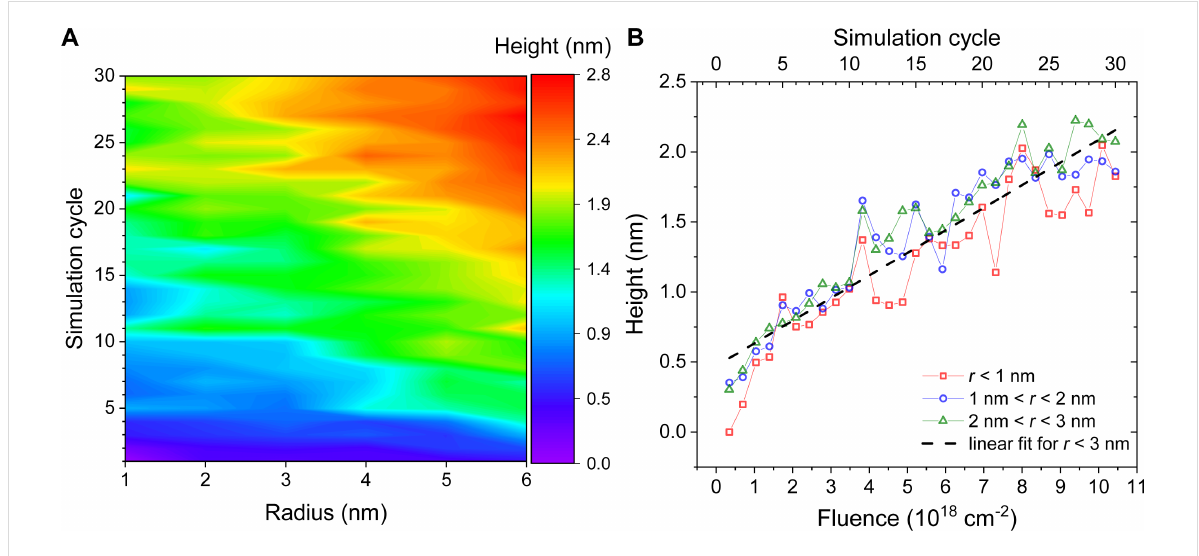
Figure 12: Evolution of the height of the grown Pt-containing structure at different FEBID simulation cycles for E dep = 300 kcal/mol. (A) Maximum height of deposited Pt structures within concentric bins of 1 nm thickness from the electron beam axis at the end of each simulated FEBID cycle. (B) Maximum height of Pt structures within the distance of 3 nm from the electron beam axis as a function of electron fluence fitted by a linear func-